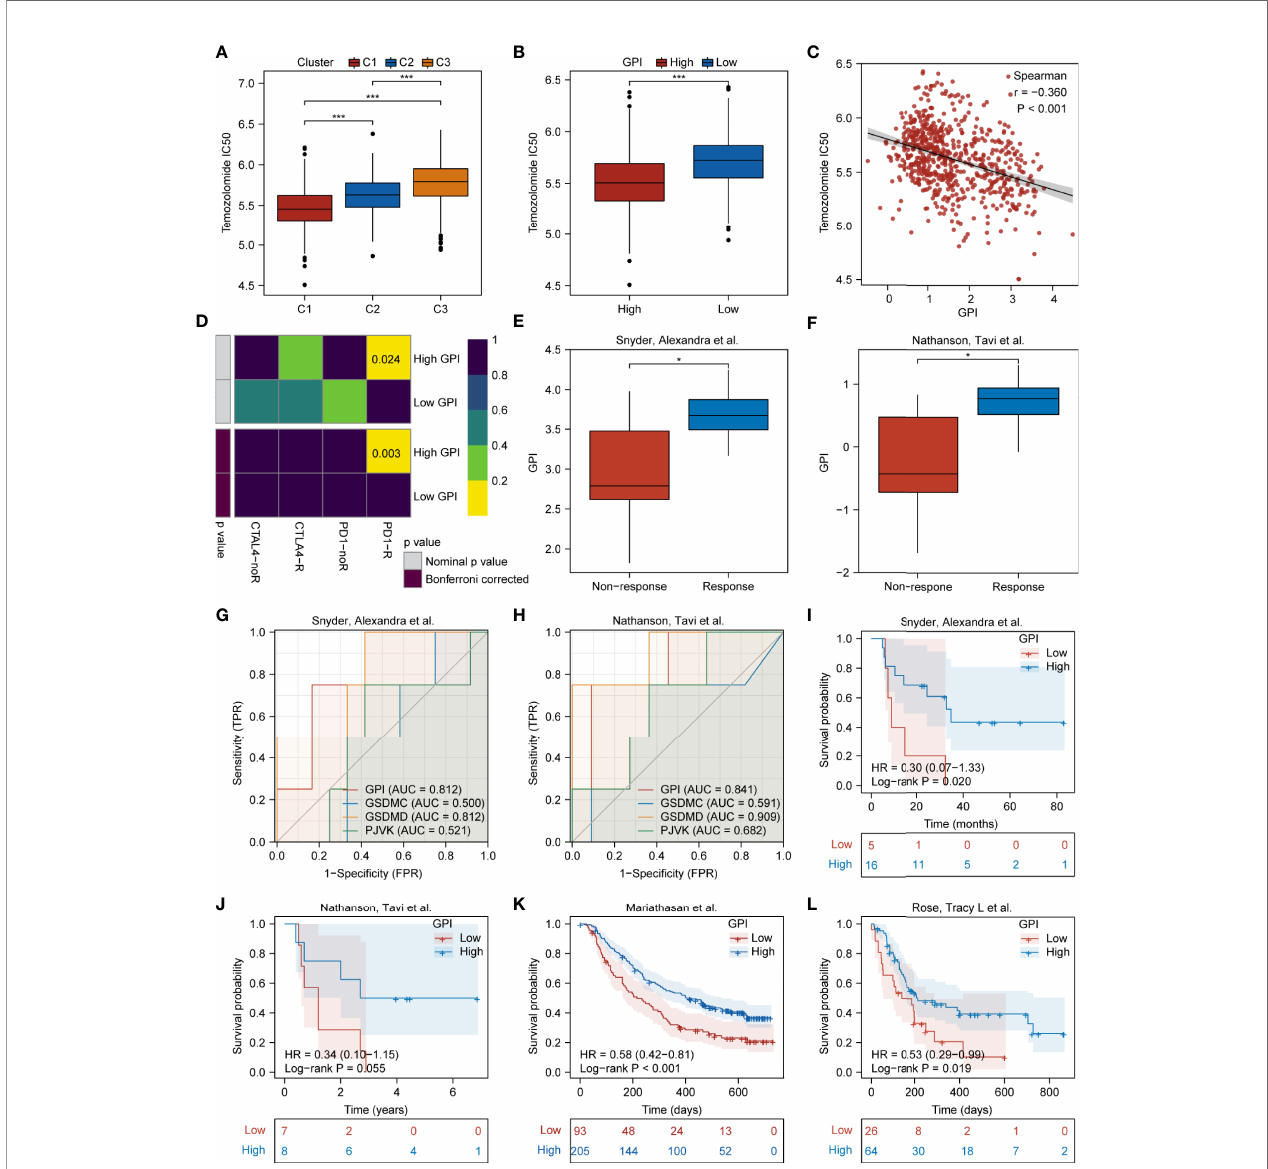
FIGURE 9 | Patients with high GPIs are more sensitive to TMZ and ICB therapy. Boxplots showing comparison of the TMZ IC 50 among the three pyroptosis subtypes (A) and between GPI-high and GPI-low groups (B) . Scatterplots showing the correlation of TMZ IC 50 with GPI (C) . (D) Submap analysis showing differences in sensitivity of GPI-high and GPI-low groups to anti-PD1 and anti-CTLA4 immunotherapy. (E, F) Boxplots showing comparison of the GPI level between responders and non-responders. (G, H) ROC curve of GPI for immunotherapy response. (I – L) Survival analysis between GPI-high and GPI-low groups in immunotherapy cohorts. *P<0.05; ***P<0.001; ns, not signi fi